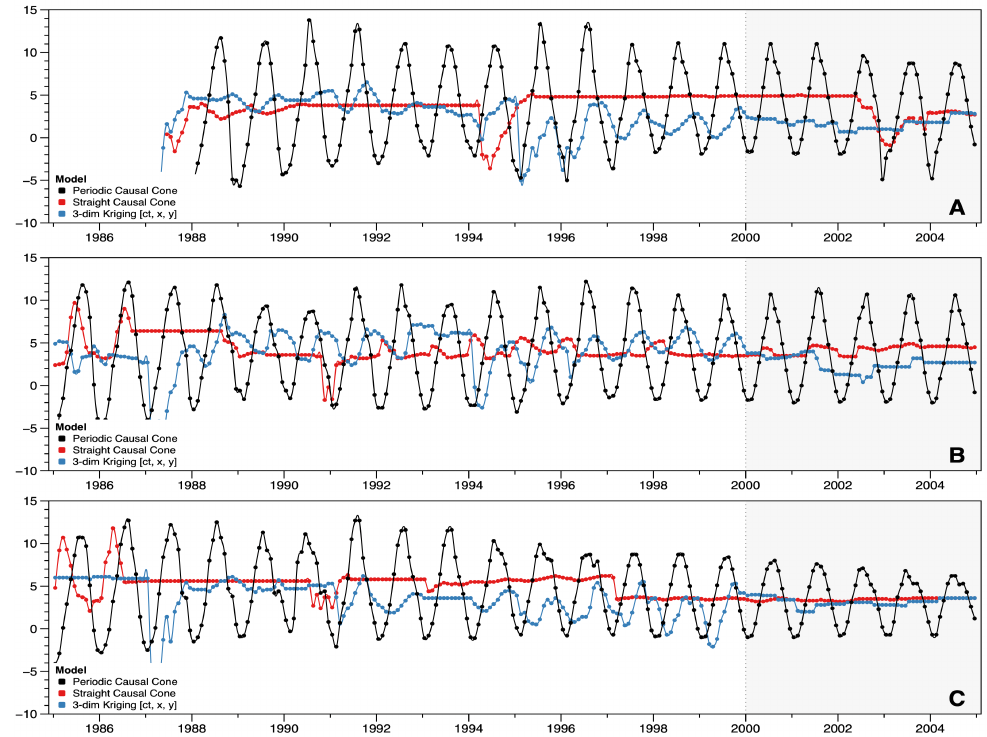
Figure 16. The same time series of Figure 15 at sites ( A )–( C ) compared with different interpolation techniques. Black: periodic Timescape, the actual case. Red: Straight cone (i.e., non-seasonal) Timescape. Blue: three-dimensional spatial Kriging. Time is in years and field values in ◦ C, error bars not